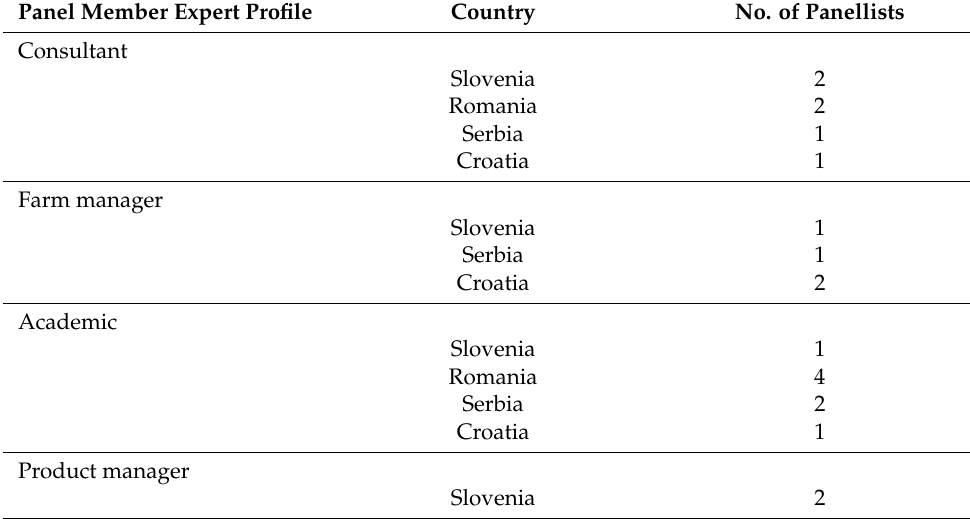
Table 2. Number of panel members by profile by country. Panel Member Expert Profile Country No. of